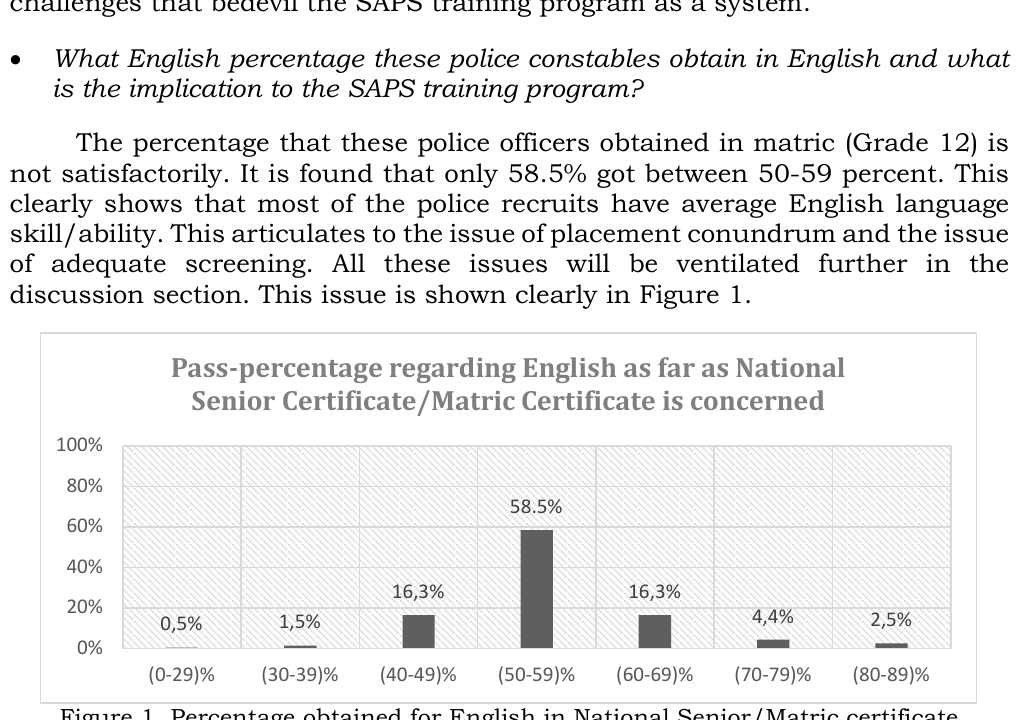
Figure 1 . Percentage obtained for English in National Senior/Matric